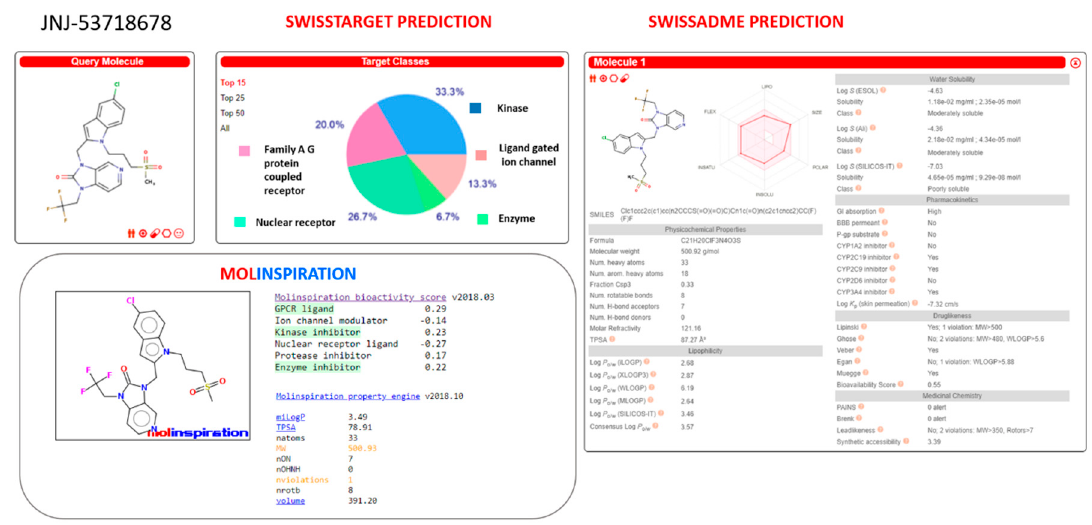
Figure 21. Prediction of ADME properties as well as of putative off-targets preferences featured by JNJ-53718678. The reported in silico evaluation was performed thanks to SwissTarget website [42,43] and to the Molinspiration Property Calculation Service [44].